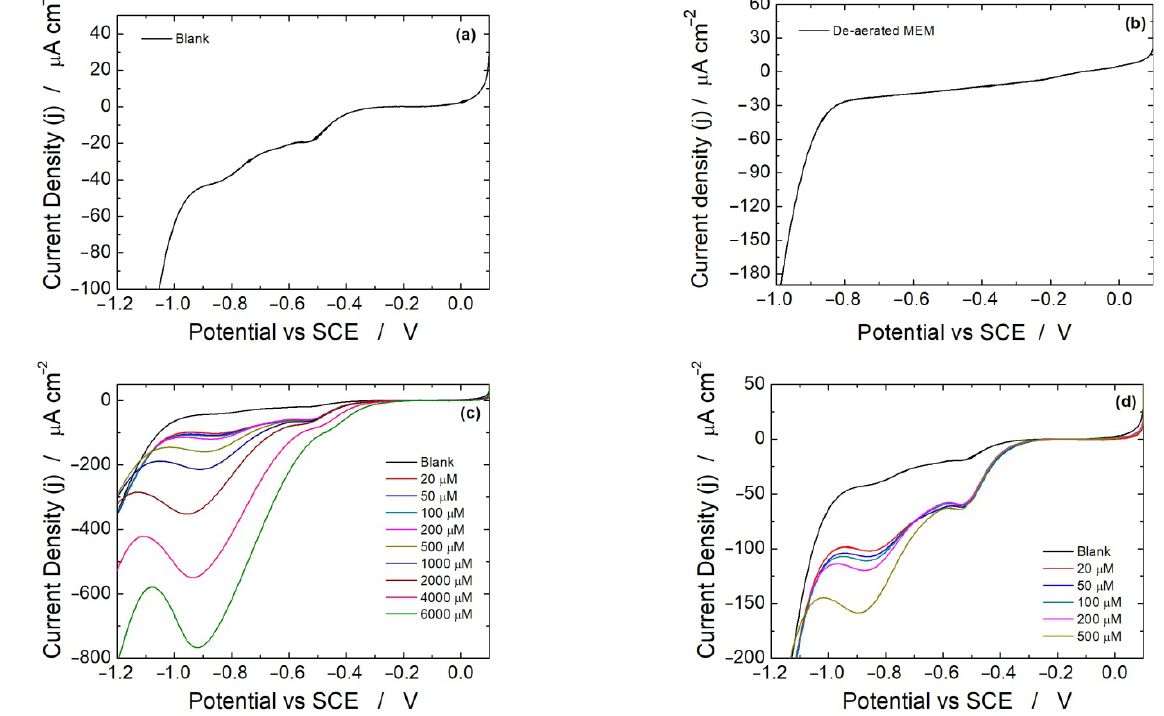
Figure 3. Linear scan voltammetry experiments carried out in: ( a ) MEM blank solution, ( b ) de-aerated MEM blank solution, ( c , d ) aerated MEM blank solution with different H 2 O 2 concentrations. In all experiments, undiluted MEM was used (N = 3).